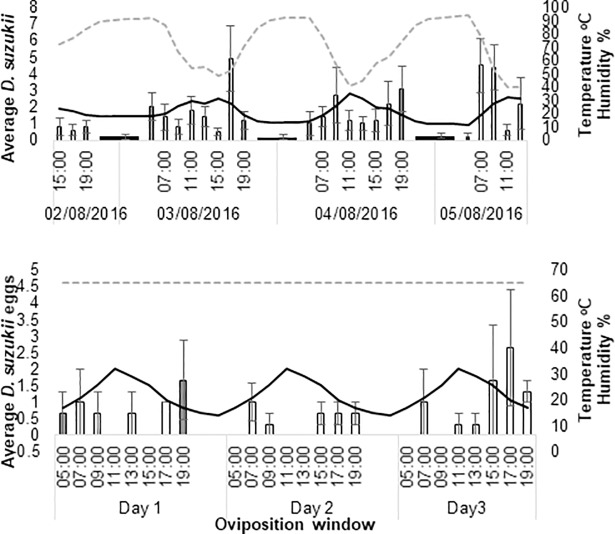
Average D. suzukii oviposition of wild and laboratory strains under August conditions within the field and laboratory.Average reproductive oviposition (+SE) of (a) wild D. suzukii in the field and (b) average oviposition (+SE) of laboratory strains in recreated August conditions within the laboratory (bars) in 2 hour ‘oviposition windows’ over three days. Average temperature (black solid line) and relative humidity (RH) (dashed grey line at x 0.5) cycled through-out. Note that relative humidity was kept constant at 65% in laboratory assays. Light is indicated by the colour of average D. suzukii bars. Black = darkness, grey = half-light and white = light.